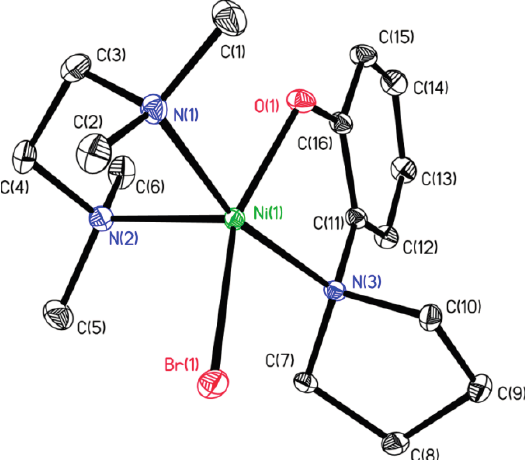
Figure 3. ORTEP diagram of 6 . All hydrogens are removed for clarity. Selected bond lengths (Å): Ni(1)-O(1) 1.9692(6); Ni(1)-N(1) 2.1465(7); Ni(1)-N(2) 2.1088(8);